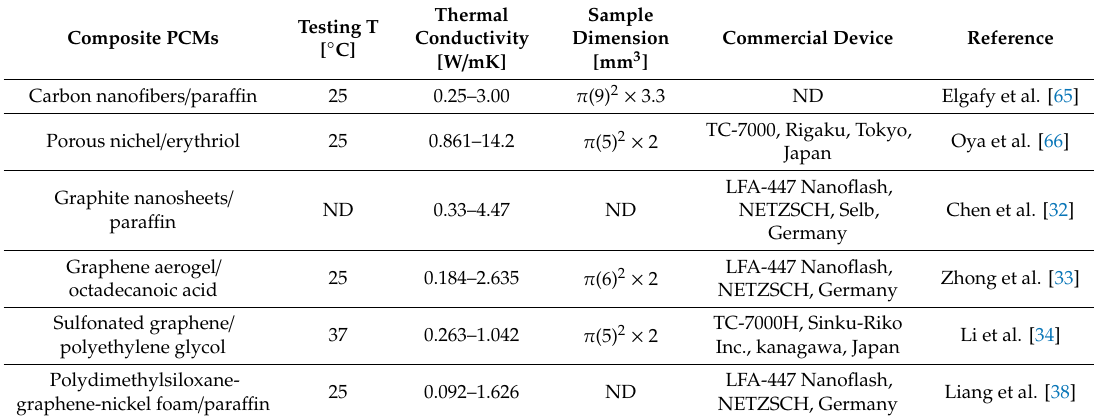
Table 4. Phases, experimental parameters and literature sources for laser flash tests on